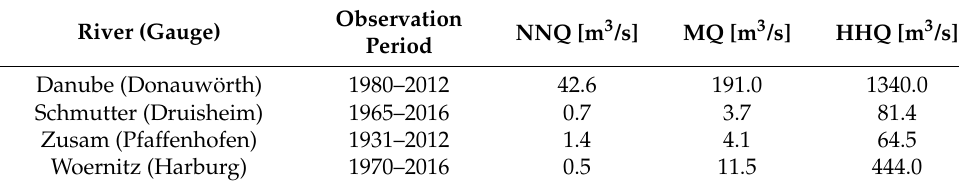
Table 1. Characteristic discharges of the Danube and its